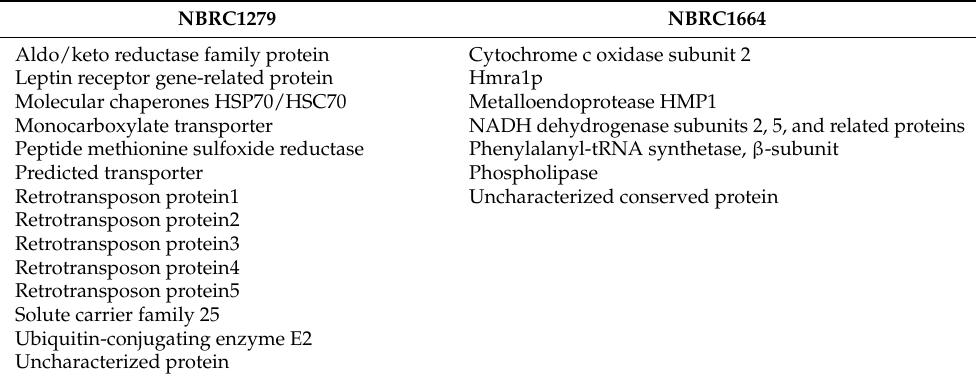
Figure 4. The Venn diagram of predicted coding sequences of P. kudriavzevii NBRC1279 and NBRC1664. Table 5. Paralogous genes of P. kudriavzevii NBRC1279 and NBRC1664.